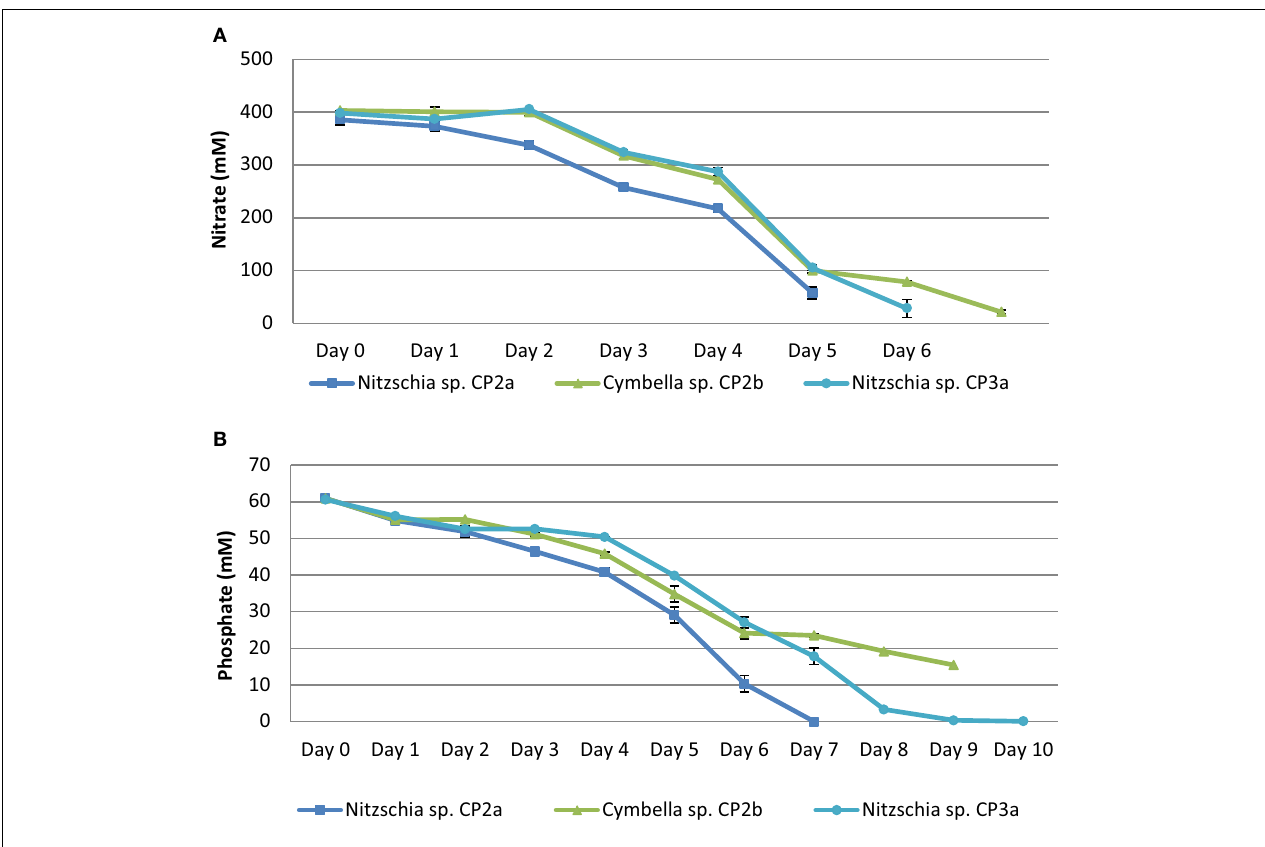
FIGURE 2 | Nitrate (A) and phosphate (B) depletion in growth medium (daily uptake) of Cymbella sp. CP2b, Nitzschia sp. CP2a, and Nitzschia sp. CP3a. Shown are mean values ± SEs from three separately-grown cultures each.